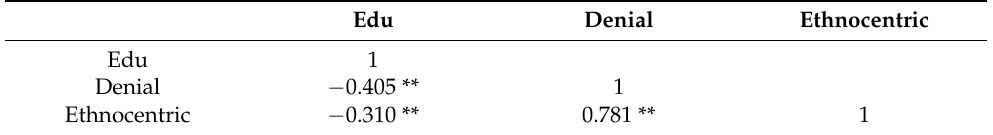
Table 8. Correlation analysis of means of ethnocentric parameters and academic education level of